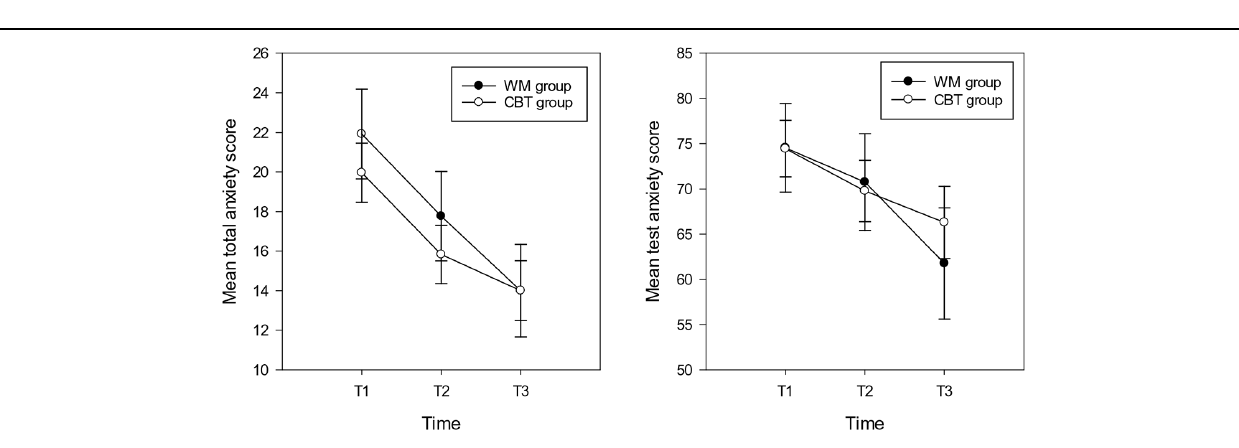
FIGURE 2 | Mean total anxiety scores (and standard errors) for total anxiety (left hand graph) and test anxiety (right hand graph) in the WM and CBT intervention groups at each time